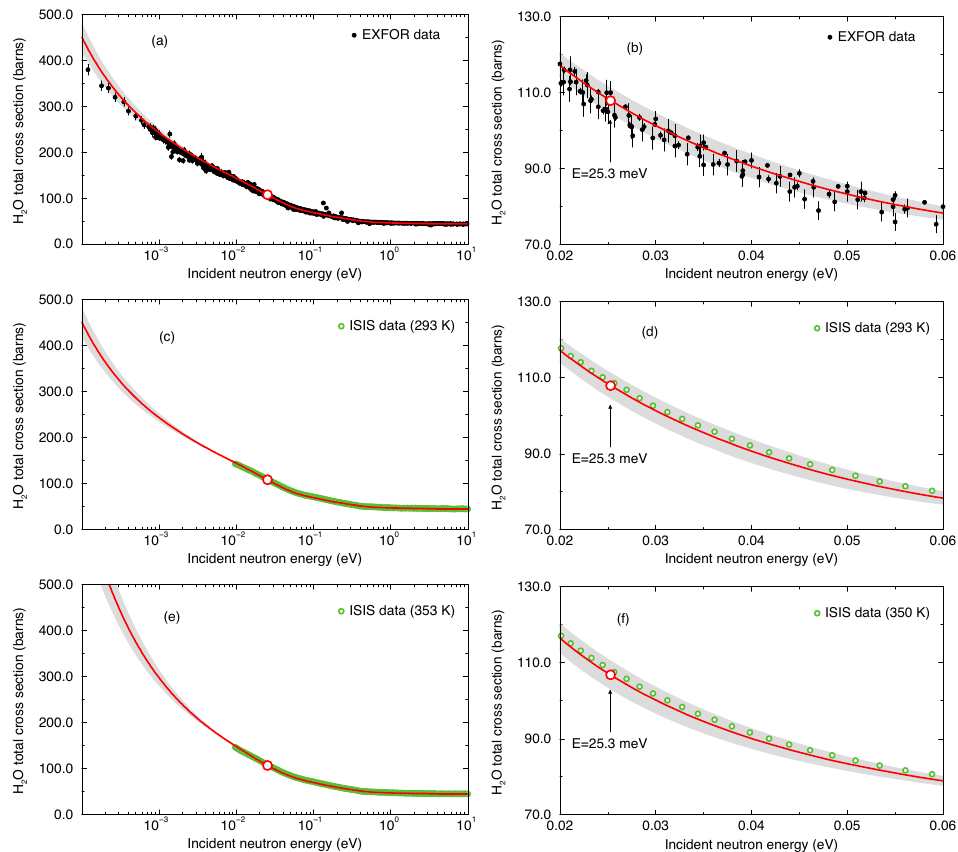
Fig. 6. Comparison of the experimental and theoretical total cross section of H 2 O. For clarity, the EXFOR data [27] and the ISIS data [26] measured at room temperature are shown separately. The grey zones represent the